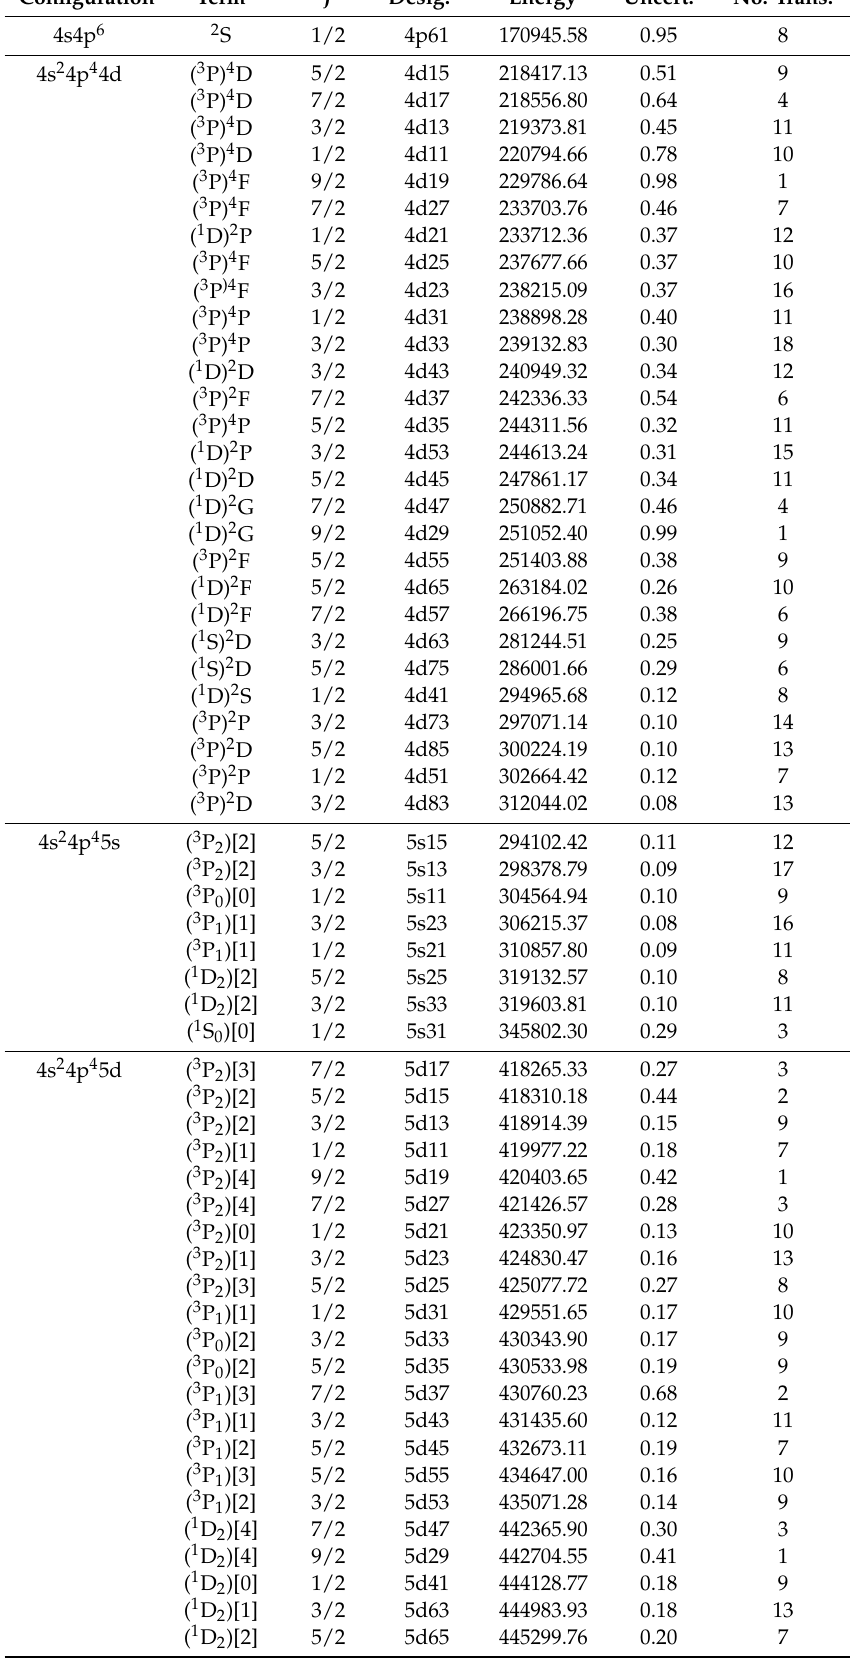
Table 3. Even parity energy levels (cm − 1 ) of Y